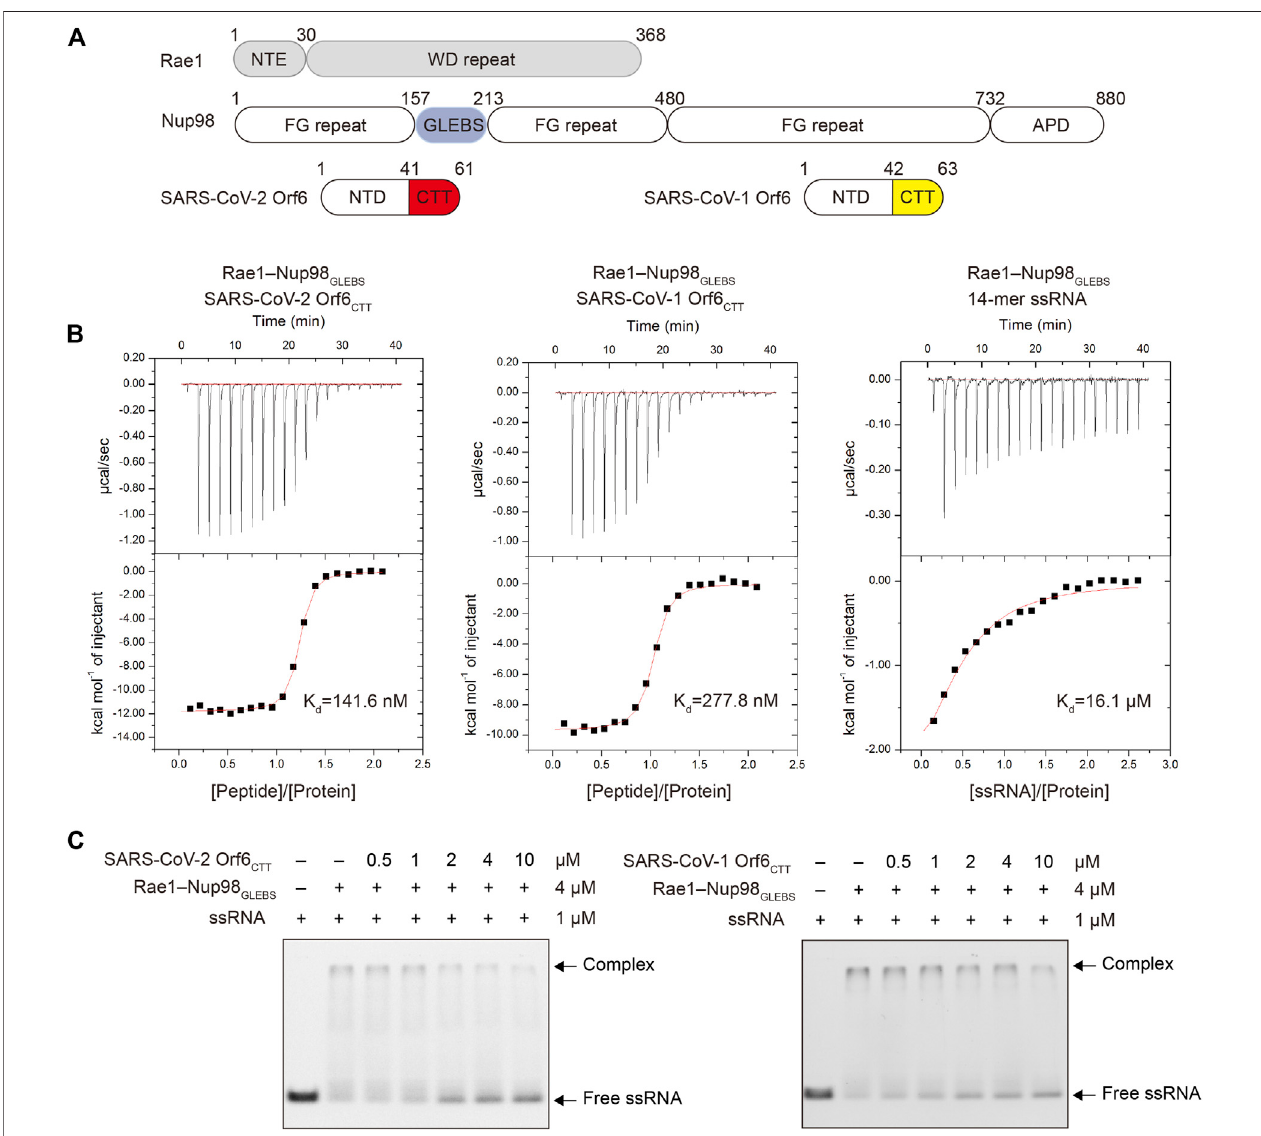
FIGURE1| SARS-CoV-2Orf6 and SARS-CoV-1 Orf6bind totheRae1 – Nup98 complex withhigh af fi nity. (A) Domain organizationofRae1, Nup98, SARS-CoV-2 Orf6and SARS-CoV-1 Orf6. (B) Binding isotherms for theinteractionsofSARS-CoV-2Orf6 CTT (left) ,SARS-CoV-1Orf6 CTT (middle) and 14-mer poly(U) ssRNA (right) with the Rae1 – Nup98 complex. (C) Competitive EMSA assays with SARS-CoVs Orf6, ssRNA and the Rae1 – Nup98 complex. After preincubation of FAM-labeled 14- merpoly(U)ssRNAandtheRae1 – Nup98complex,themixturewasfurtherincubatedwithincreasingamountsofSARS-CoV-2 (left) andSARS-CoV-1 (right) Orf6 peptides and analyzed by EMSA